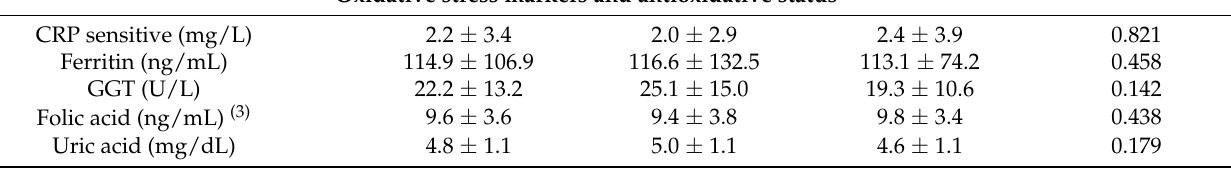
Abbreviations: ALAT, alanine aminotransferase; ASAT, aspartate aminotransferase; BMI, body mass index; BP, blood pressure; ∆ cortisol (m–e), cortisol difference morning–evening; CRP, C-reactive protein; ECLIA, electrochemiluminescence immunoassay; FLI, fatty liver index; FPG, fasting plasma glucose; GGT, gamma- glutamyltransferase; HbA1c, glycated hemoglobin A1c; HDL-C, high-density lipoprotein cholesterol; HOMA index, homeostasis model assessment index; ITT, intention-to-treat population; LDL-C, low-density lipoprotein cholesterol; NCEP, National Cholesterol Education Program; SD, standard deviation; TC, total cholesterol; TG, triglycerides; WC, waist circumference. (1) High stress (HS) group: participants with a total PSQ 30 score of 0.500–0.656; (2) Very high stress (VHS) group: participants with a total PSQ 30 score > 0.656; (3) n = 60, data not available for one participant (hemolytic blood sample); p Value: Mann–Whitney U test or Fisher’s exact